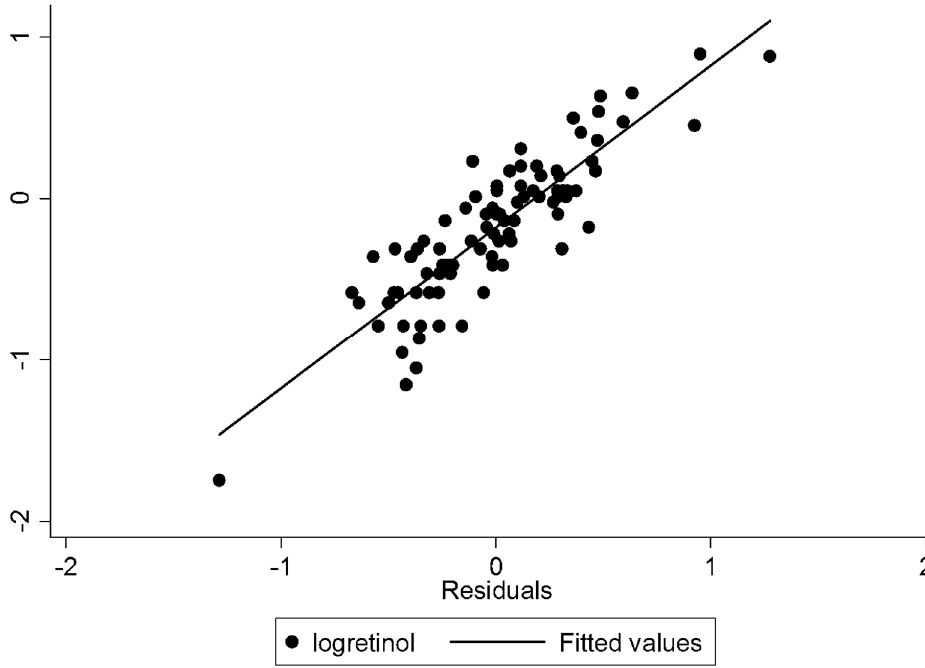
Figure 2. The analysis of residues of the model of multiple linear regression for variable serum retinol levels response* according to the explanatory variables.